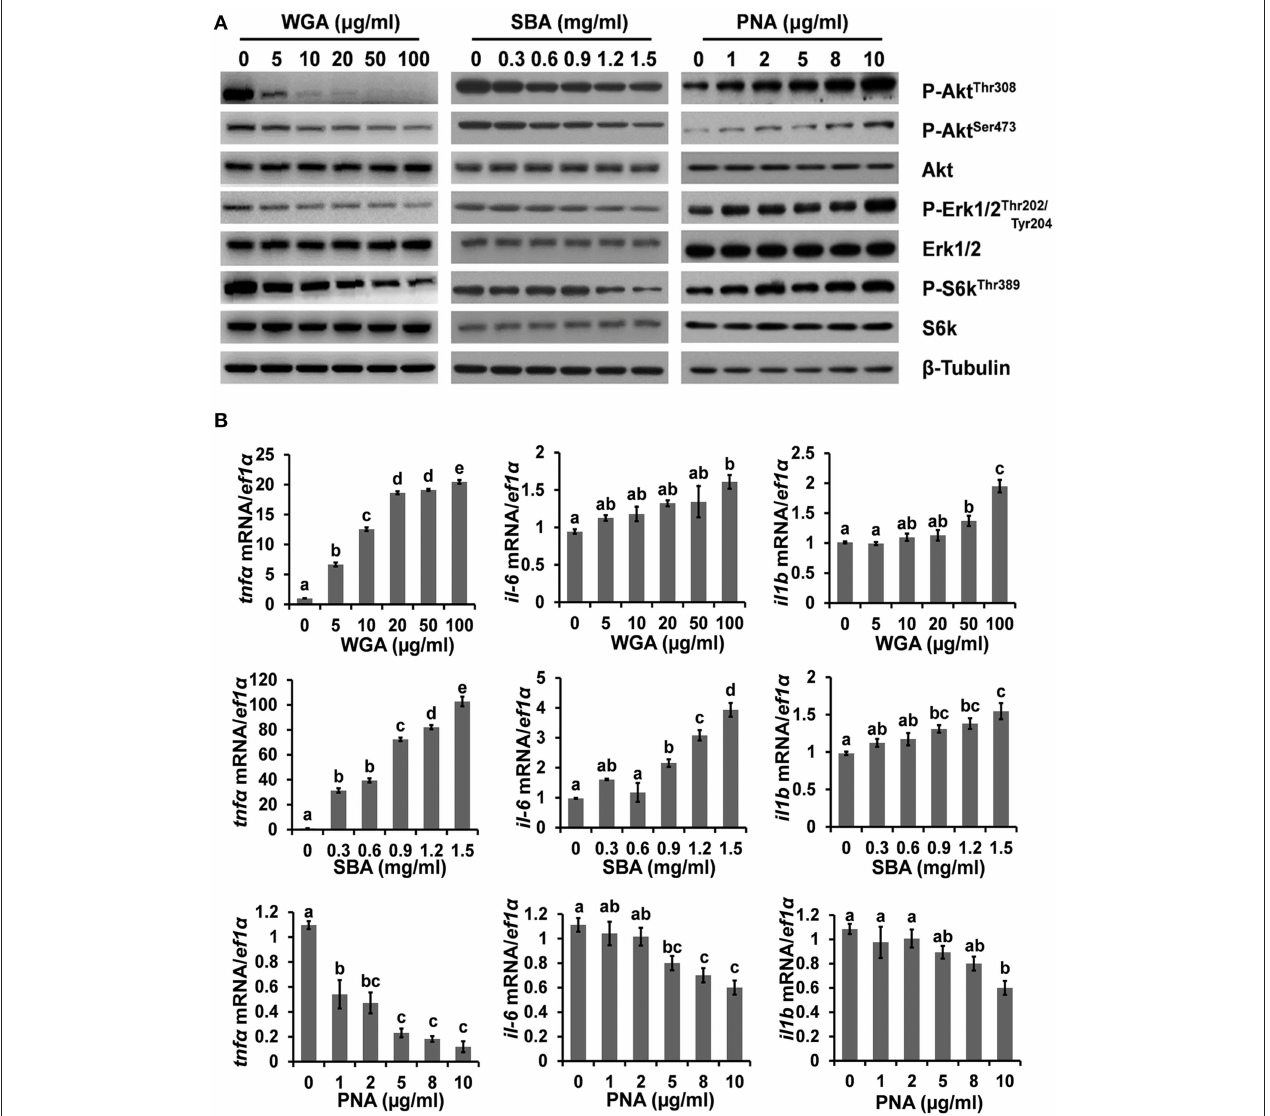
FIGURE 3 | The influence of lectins on intracellular signaling. (A) Cells were treated with series concentrations of WGA, SBA, or PNA for 4h and stimulated with complete medium for 15min. The levels and activities of key signaling molecules involved in survival and stress pathways were examined by western blot. (B) The mRNA expressions of il-1b, il-6, and tnf α were analyzed by quantitative real-time PCR after lectins treatments. Results were represented as means with standard errors ( n = 6) and analyzed using One-Way ANOVA. Values with different letters in the same column (a–e) were significantly different ( p < 0.05) from each other.